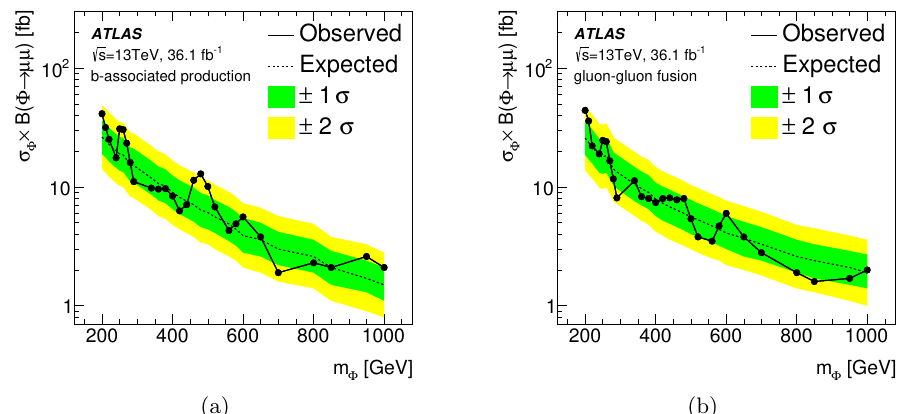
Figure 4 . The observed and expected 95% CL upper limits on the production cross section times branching ratio for a massive scalar resonance produced via (a) b -quark associated production and (b) gluon-gluon fusion.